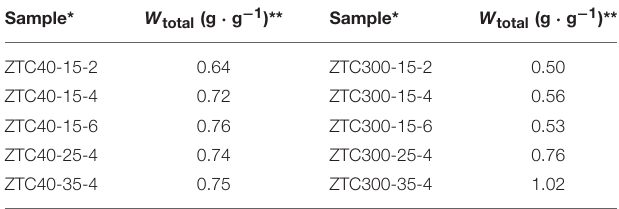
Frontiers in Materials |